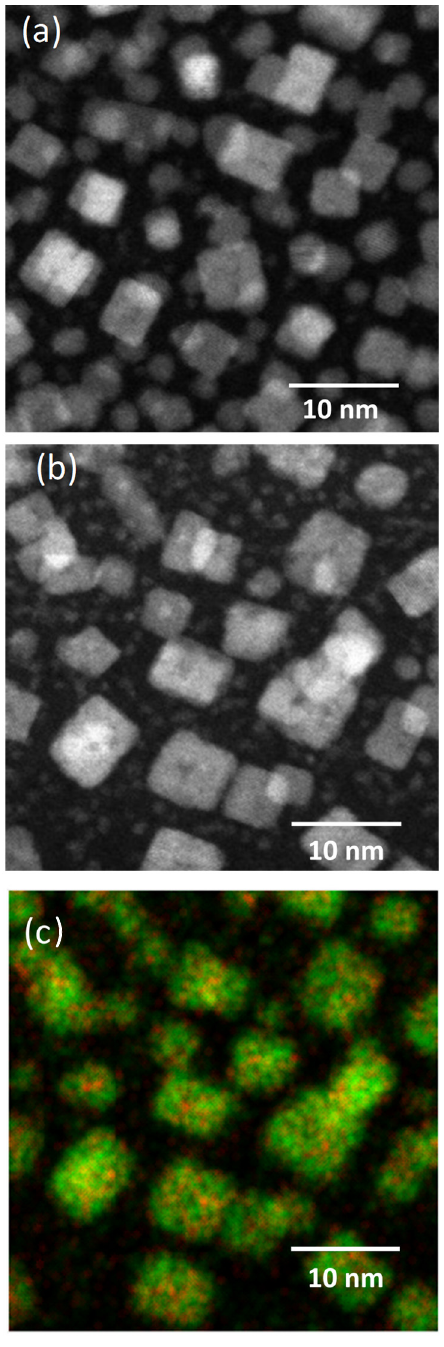
Figure 4. STEM HAADF imaging and EDS mapping of nanoparticles generated by TBA: ( a ) HAADF of CeO x and ( b ) HAADF of Eu:CeO x ; ( c ) Ce L and Eu L map of the Eu:CeO x NPs (Eu L— red , CeL— green ).